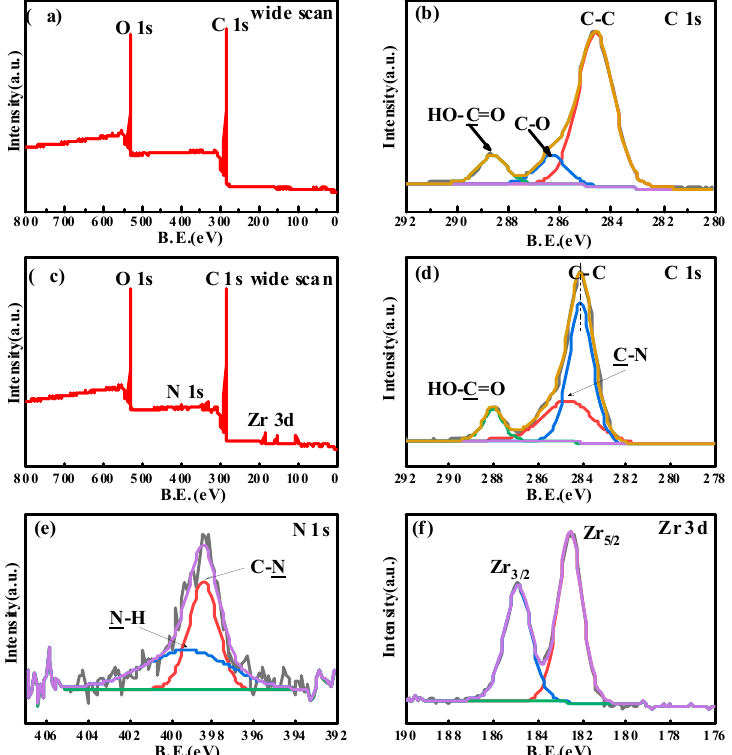
Figure 3. XPS spectrum of carbon fiber surface elements and peak-fitting curves of C1s, N1s and Zr3d: ( a , b ) CF-COOH; ( c – f ) MOF/CF-9.